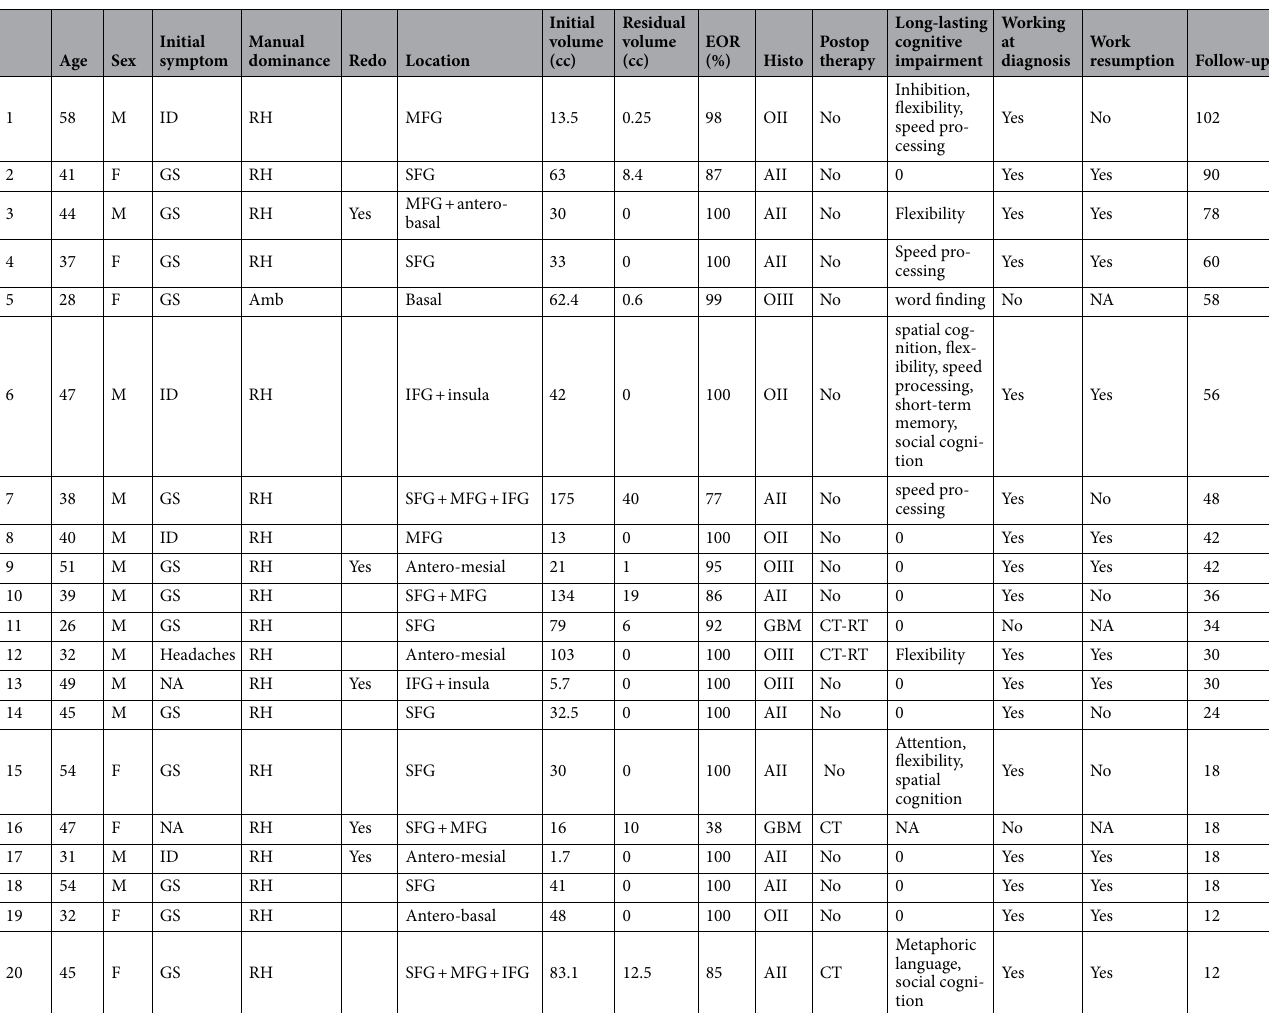
Table 1. Patients and tumors characteristics. GS generalized seizure, ID incidental discovery, RH right- handed, Amb ambidextrous, MFG middle frontal gyrus, SFG superior frontal gyrus, IFG inferior